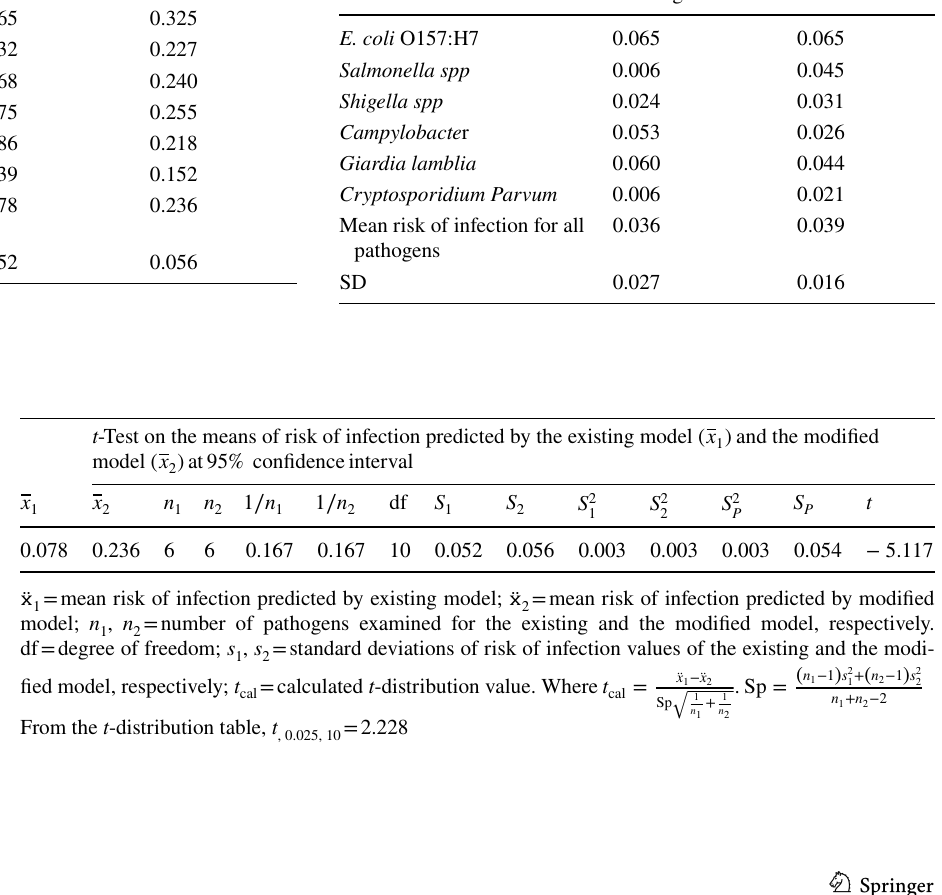
Table 14 Linear comparison of risks of infections obtained using the existing and the modified models Pathogen